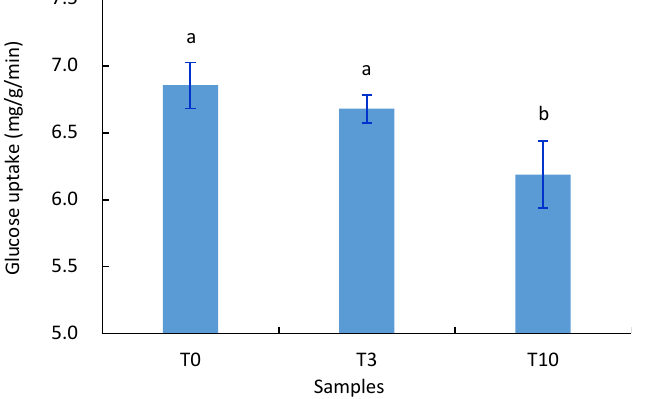
Figure 2. Effects of D. officinale on the glucose uptake of S. cerevisiae . T0, T3, and T10 were the samples with 0, 30, and 100 g/L of D. officinale , respectively. Different letters indicate significant differences at p < 0.05.